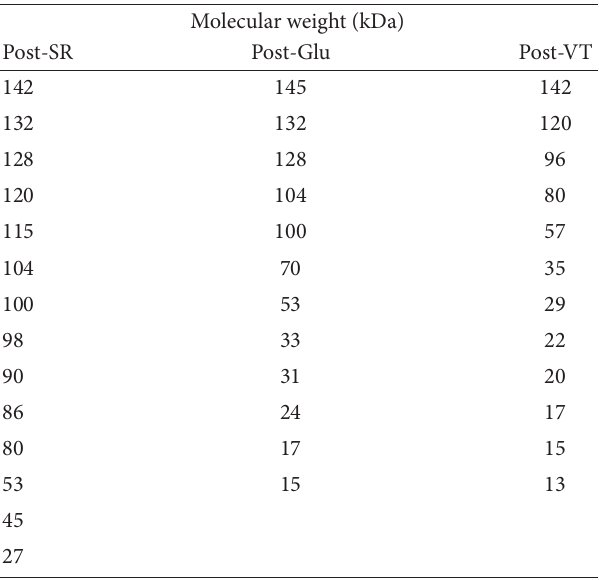
Table 8: Antigens decreasing in band frequencies revealed by sera after spontaneous remission, Glucantime, or VT treatment in